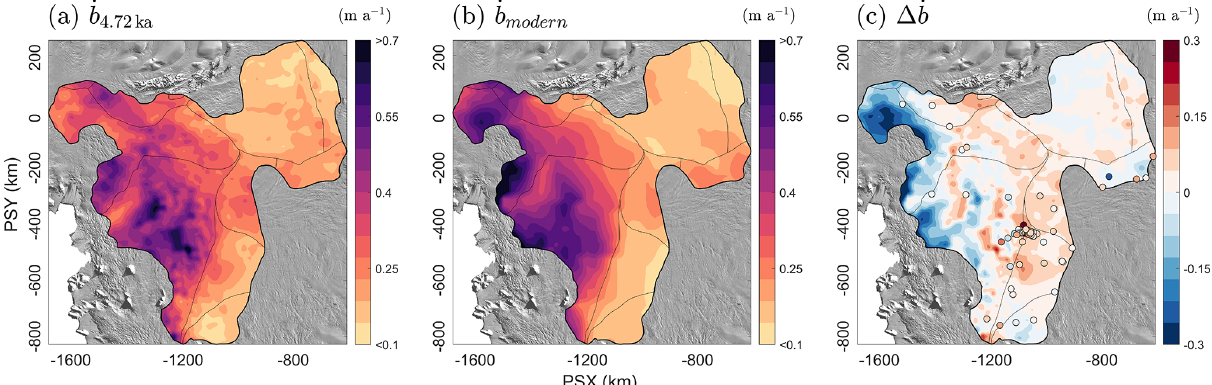
Figure 3. Gridded estimates of ice-equivalent accumulation rates for the last 4.72ka and modern times. (a) Gridded accumulation rates inferred from the 4.72ka IRH. (b) Modern (1979–2019) modelled SMB rates from RACMO2. (c) Difference between 4.72ka-to-present and modern accumulation rates (red = 4.72ka-to-present accumulation higher than modern times, blue = 4.72ka-to-present accumulation lower than modern times). The dots represent the difference between the value for the nearest grid cell in (a) and time-averaged accumulation rates at each of the 79 core locations (see Sect. 2.4; Fig. S6). The background image is the 2014 MODIS mosaic of Antarctica (Haran et al.,